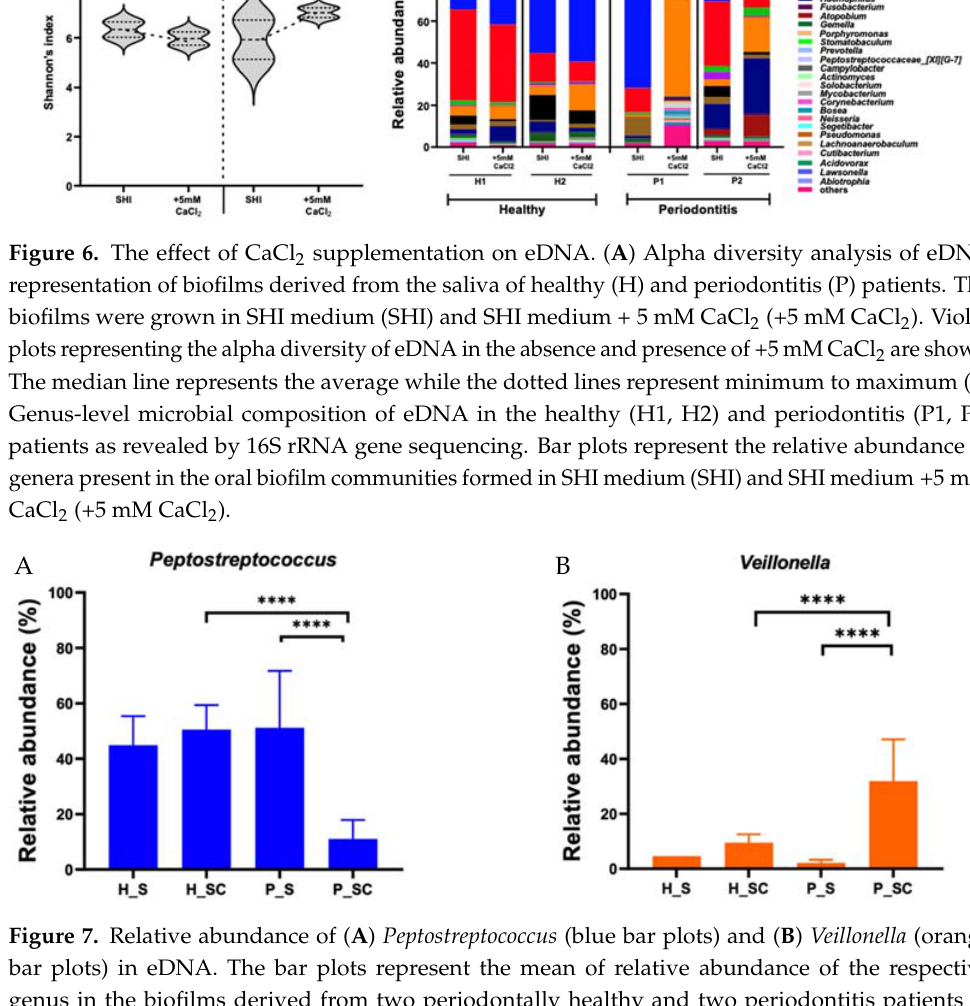
Figure 7. Relative abundance of ( A ) Peptostreptococcus (blue bar plots) and ( B ) Veillonella (orange bar plots) in eDNA. The bar plots represent the mean of relative abundance of the respective genus in the biofilms derived from two periodontally healthy and two periodontitis patients in both SHI (_S) and SHI + 5 mM CaCl 2 (_SC). Error bars represent standard error of mean (SEM). **** Represents p ≤ 0.0001.